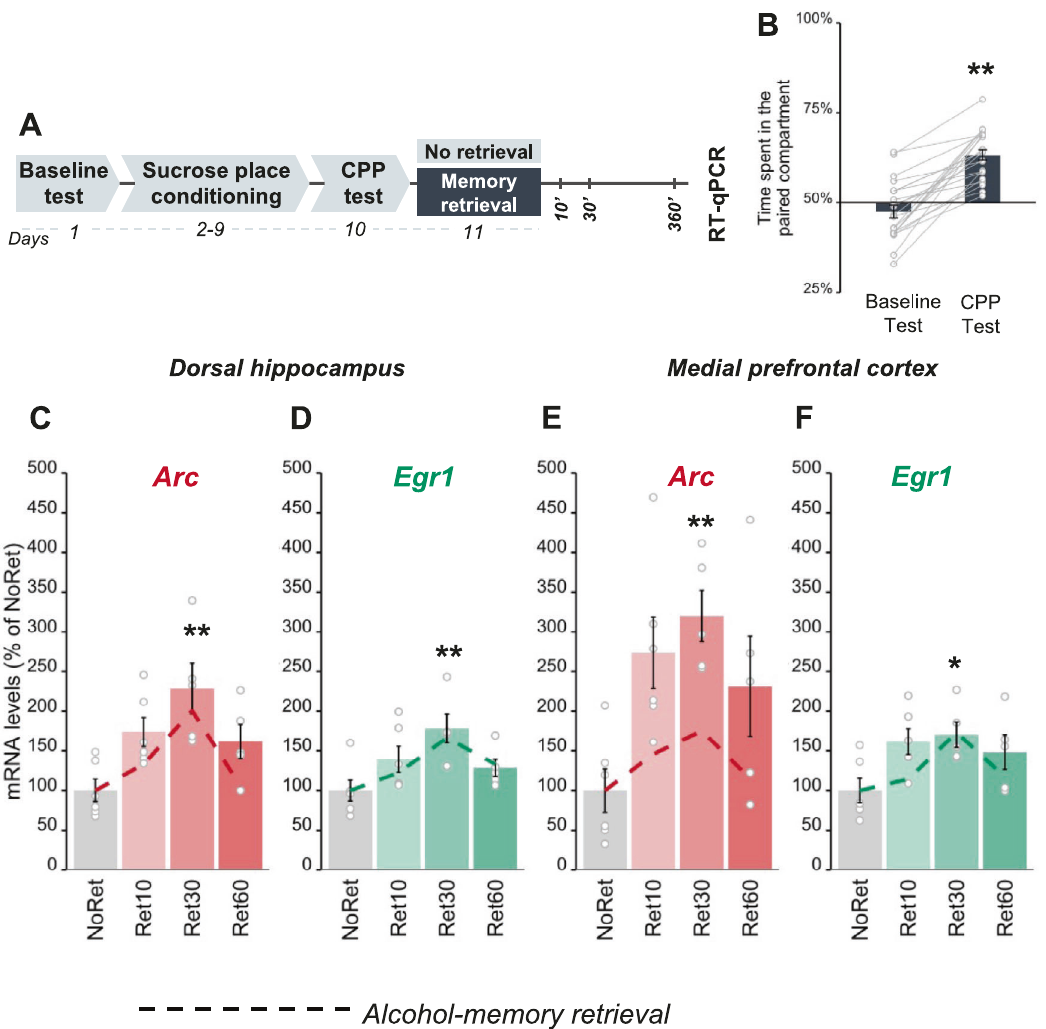
Fig. 4 Sucrose memory retrieval triggers upregulation of Arc and Egr1 in the dorsal hippocampus and medial prefrontal cortex. A Schematic illustration of the experimental design and timeline. B Place preference scores, expressed as means ± S.E.M. of the percent of time spent in the sucrose-paired compartment (t (21) = 8.45, p < 0.0001); C – F mRNA levels, normalized to Gapdh , expressed as means ± S.E.M. of the percent of change, as compared with the control group (No Retrieval). qRT-PCR analysis revealed post-retrieval alterations in gene expression (one-way MANOVA; DH: Time (F (6,34) = 2.82, p < 0.05); mPFC: Time (F (6,34) = 2.13, p = 0.07)). Arc mRNA levels were transiently increased in the DH (NoRet vs Ret30 ’ : p < 0.01) ( C ) and mPFC (NoRet vs Ret30 ’ : p < 0.01) ( E ), while Egr1 expression was increased in the DH (NoRet vs Ret30 ’ : p < 0.01) ( D ) and the mPFC (NoRet vs Ret30 ’ : p < 0.05) ( F ). mRNA expression levels after alcohol memory retrieval are shown as dashed lines. * p < 0.05; ** p < 0.01; n = 9 – 6 per